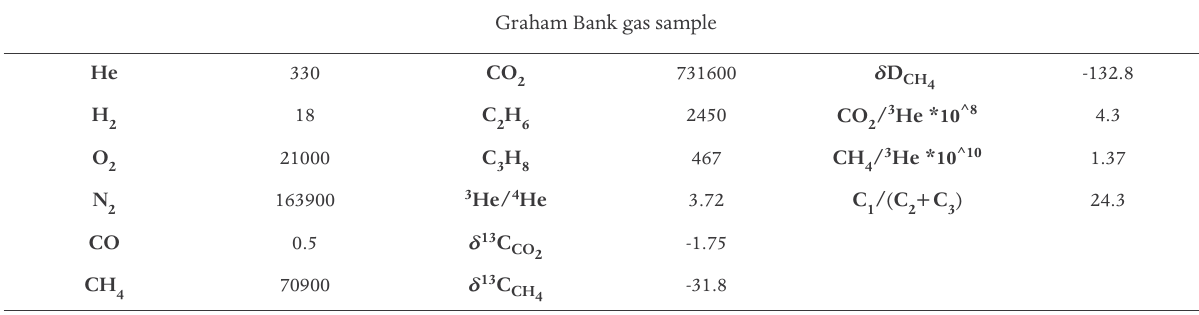
Table 1. Chemical composition and isotope signature of the gas sample collected. All the chemical concentrations are expressed in ppm vol. The helium isotope composition is expressed as R/Ra, where R is the 3 He/ 4 He ratio in the sample and Ra is the same ratio in the atmos- phere. The carbon isotope compositions are given in delta per mil versus V-PDB scale. d D CH4 is expressed in delta per mil vs V-SMOW scale. C /(C +C ) is “Barnard parameter” defined as the ratio between methane (CH 1 2 3